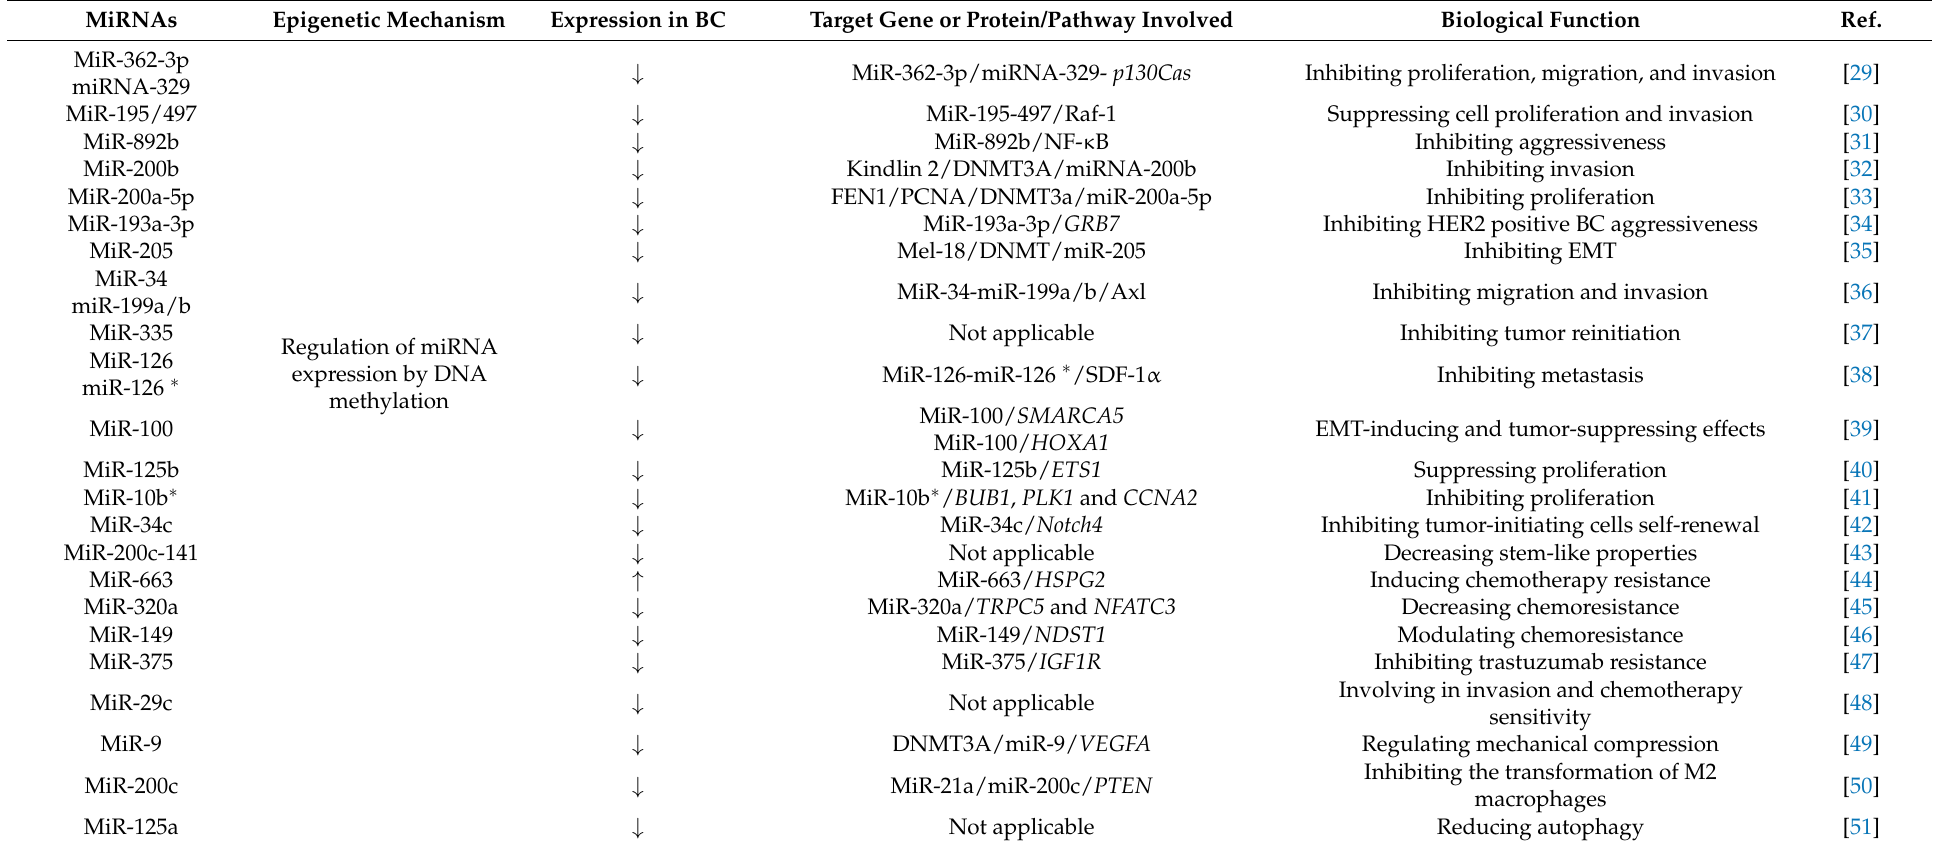
Table 1. Crosstalk between different methylation types and miRNAs in